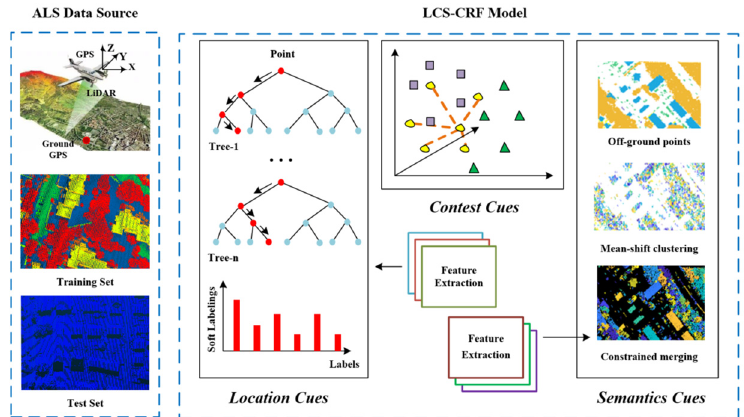
Figure 1. Flowchart of the location-context-semantics-based conditional random field (LCS-CRF) algorithm integrating location, context, and semantics cues. ALS = airborne laser scanning.